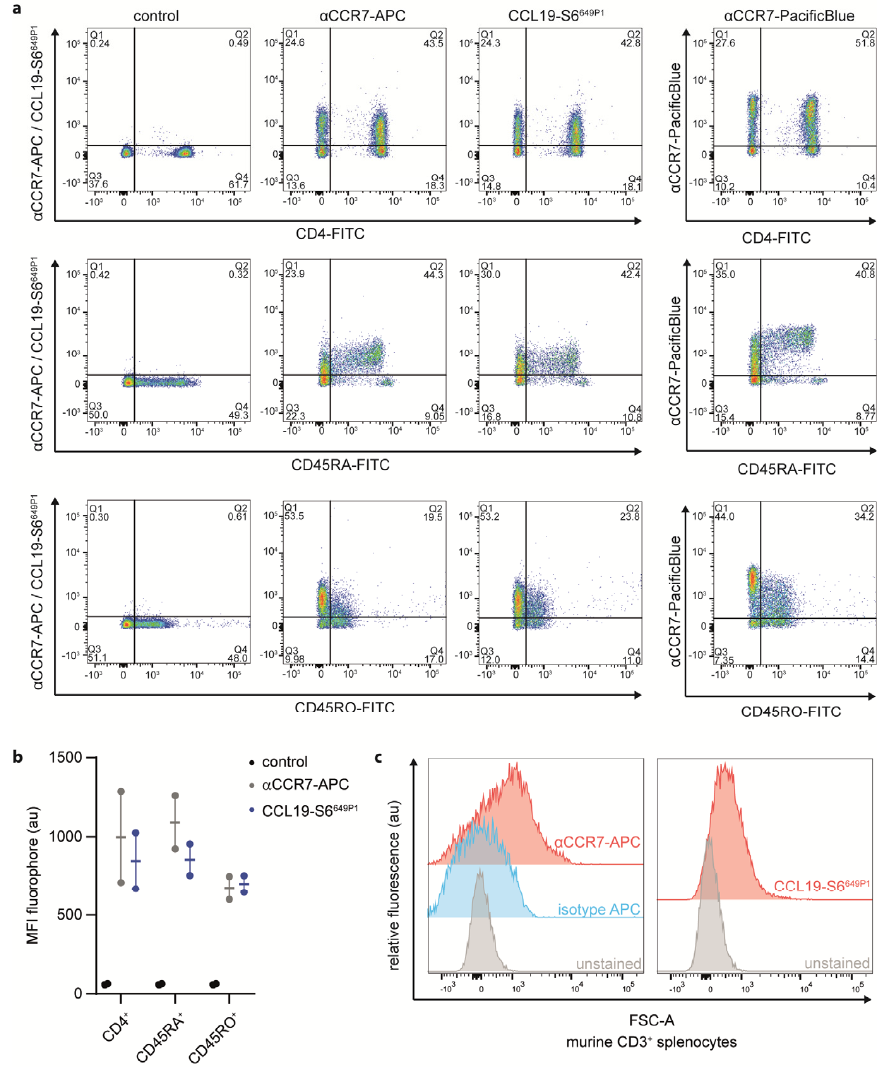
Figure 6. CCL19-S6 649P1 is a versatile tool to stain CCR7-expressing primary human and mouse T cell sub-populations. Primary human peripheral blood CD3-sorted T cells ( a , b ) and mouse splenic T cells ( c ) were stained with 50 nM CCL19-S6 649P1 for 20 min at 22 °C together with either anti-huCD4-FITC, anti-huCD45RA-FITC, anti-huCD45RO-FITC, anti-huCCR7-APC, anti-huCCR7-PacificBlue, anti-muCD3-PE, or anti-muCCR7-APC conjugated antibodies, respectively, and analyzed by flow cytometry. One ( a ) out of the two ( b ) human donors, or three ( c ) independent experiments with comparable results are shown.